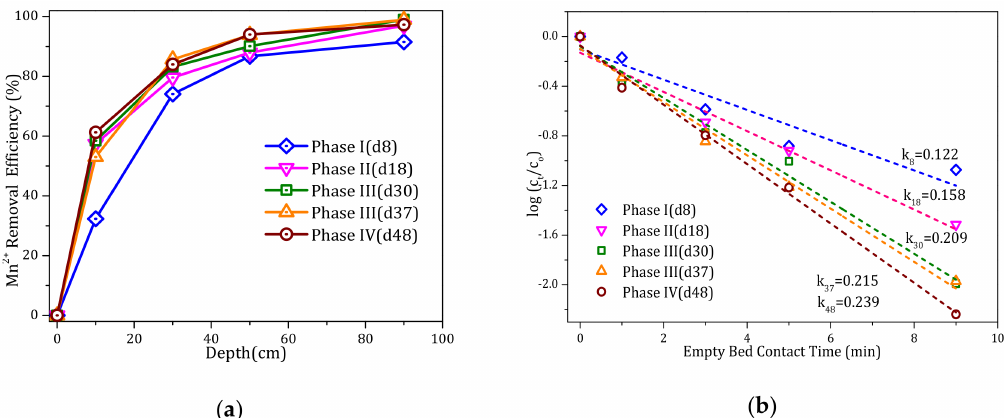
Figure 5. ( a ) Manganese (Mn 2 + ) removal e ffi ciency with filter column depth during di ff erent phases, and ( b ) linear regression analysis of Mn 2 + depletion with the empty bed contact time during di ff erent phases. Day (d) and rate constant (k).